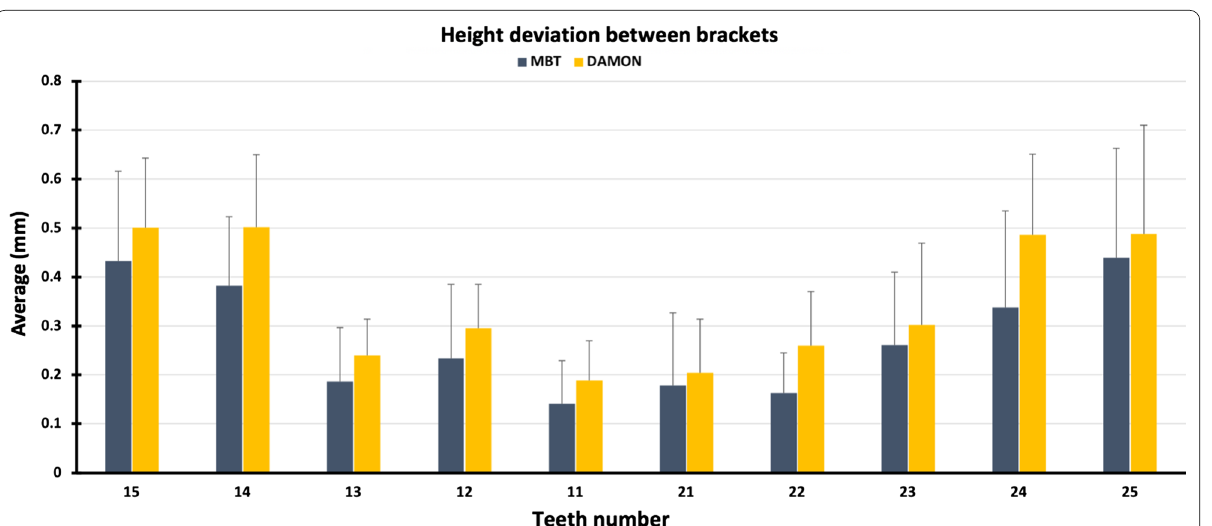
Fig. 7 Differences in height on each tooth between direct and indirect methods using MBT and Damon